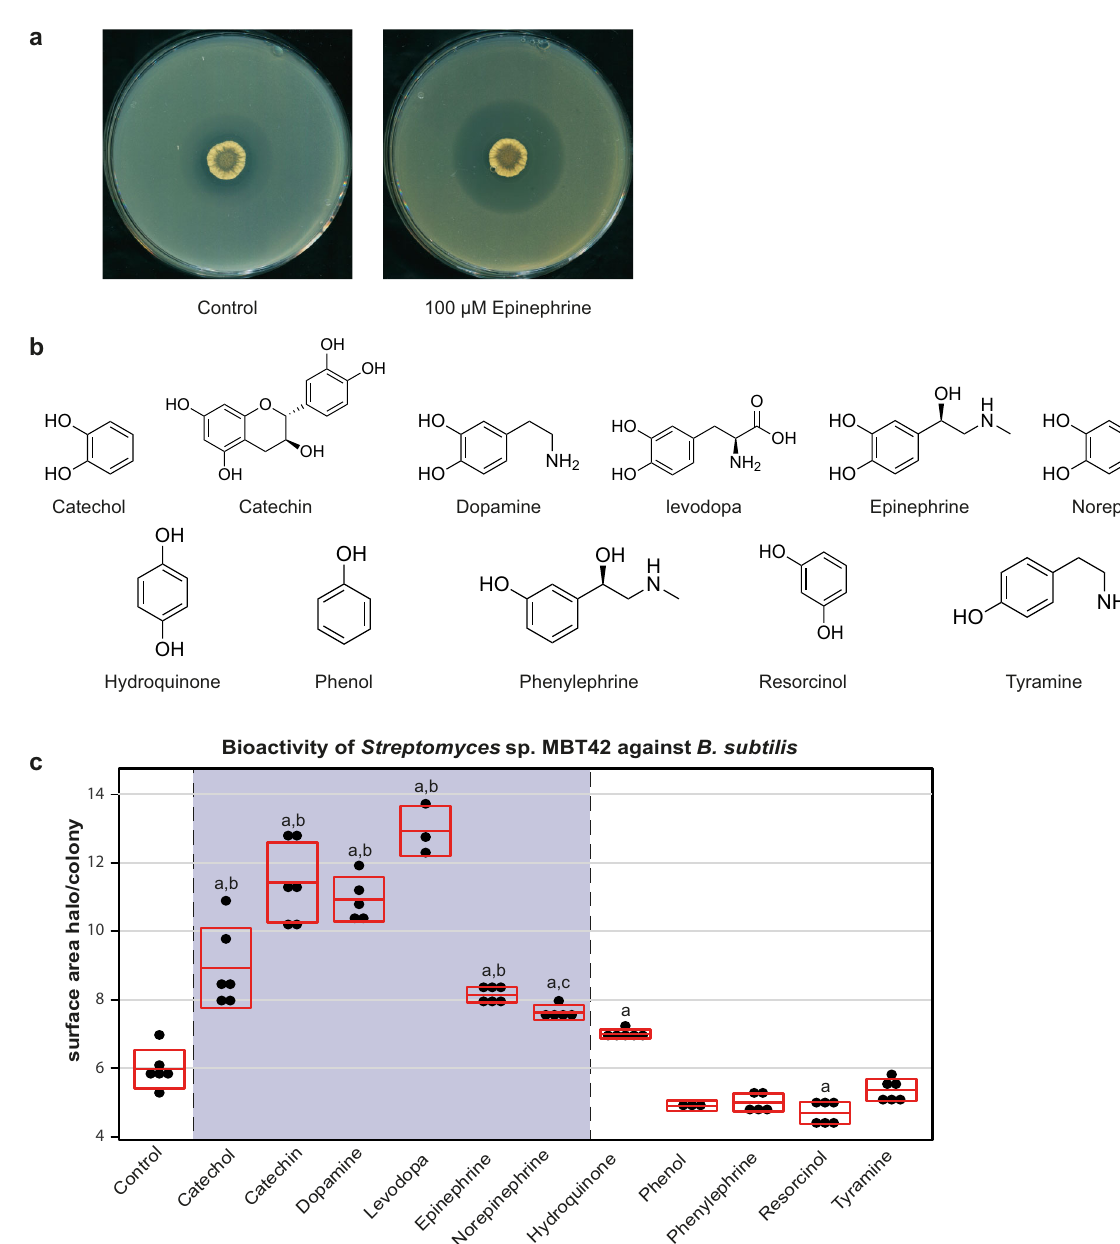
Fig. 1 The catechol-moiety is key to the eliciting effect of epinephrine on Streptomyces sp. MBT42. a Streptomyces sp. MBT42 was grown on NA supplemented with and without 100 µ M epinephrine ( n = 3). After 4 days of growth, plates were overlaid with B. subtilis to test for antimicrobial activity. Note the increased semi-transparent halo surrounding Streptomyces sp. MBT42 grown in presence of epinephrine. b An overview of the structurally related compounds tested. c Effect of different compounds on the bioactivity of Streptomyces sp. MBT42 against B. subtilis . Bioactivity was quanti fi ed by measuring the ratio between the surface area of the inhibition zone and the colony (data represent two independent experiments, the number of biologically independent replicates ( = n ) for each group is indicated in the fi gure, mean and standard deviation are indicated in red, the grey box highlights the response to compounds with a catechol moiety). One-way ANOVA, followed by a post hoc Tukey ’ s honest signi fi cant difference (HSD) test, was performed to compare the difference in bioactivity between the growth conditions. The symbols indicate a signi fi cant increase in bioactivity compared to ( a ) the control, ( b ) to compounds lacking a catechol moiety, and ( c ) to compounds lacking a catechol moiety except